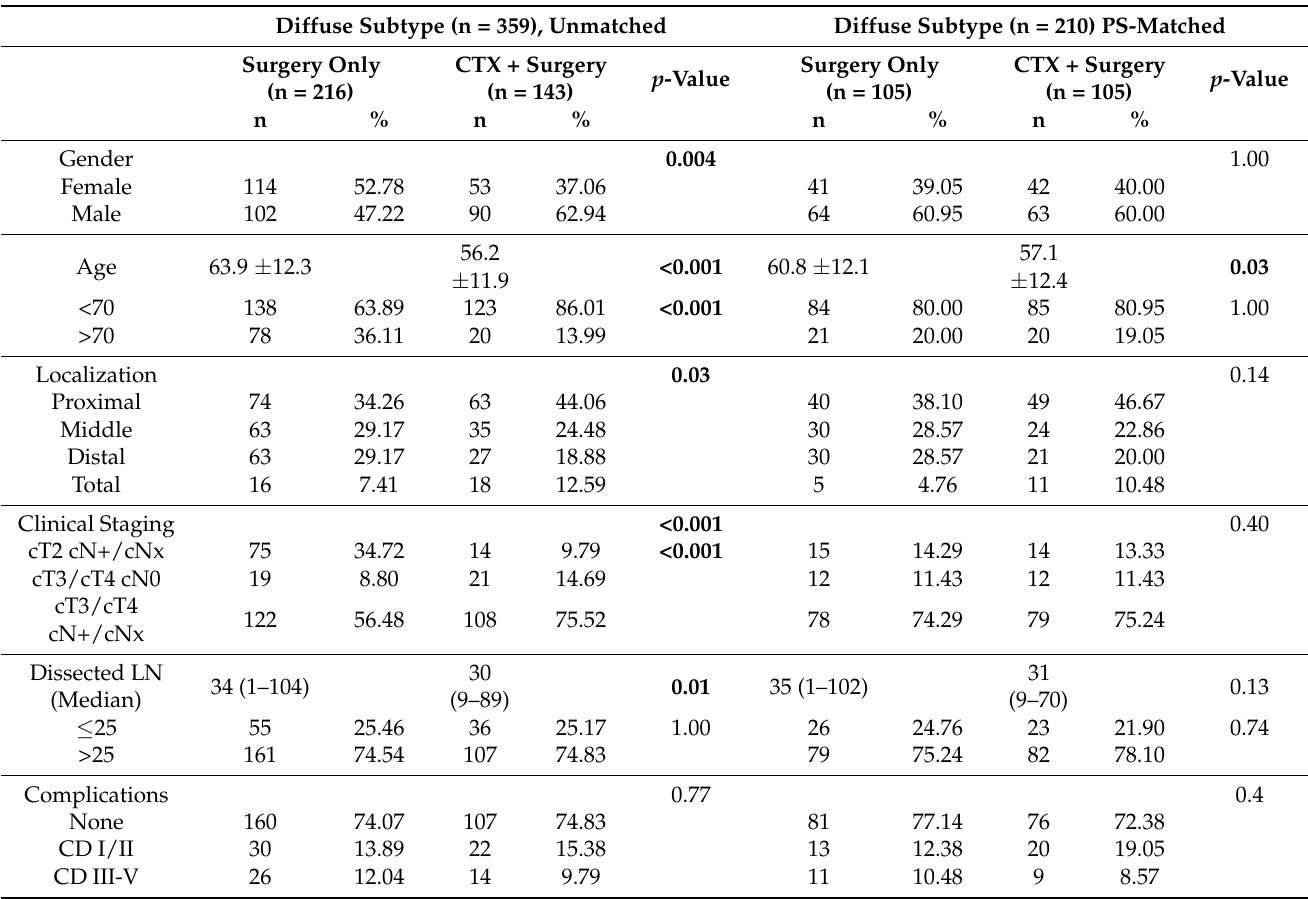
Table 2. Baseline characteristics for patients with diffuse Lauren subtype before and after